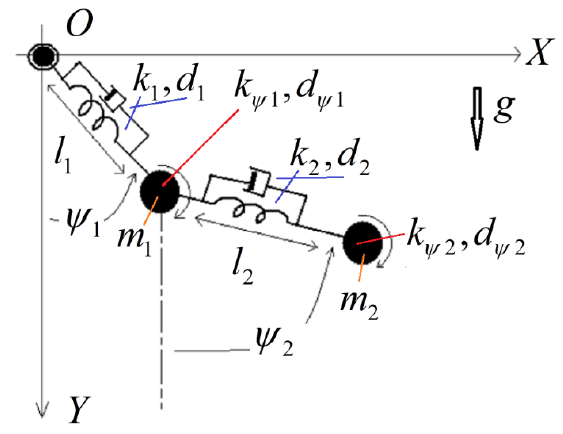
Figure 1. Representation of the flexible link robot.